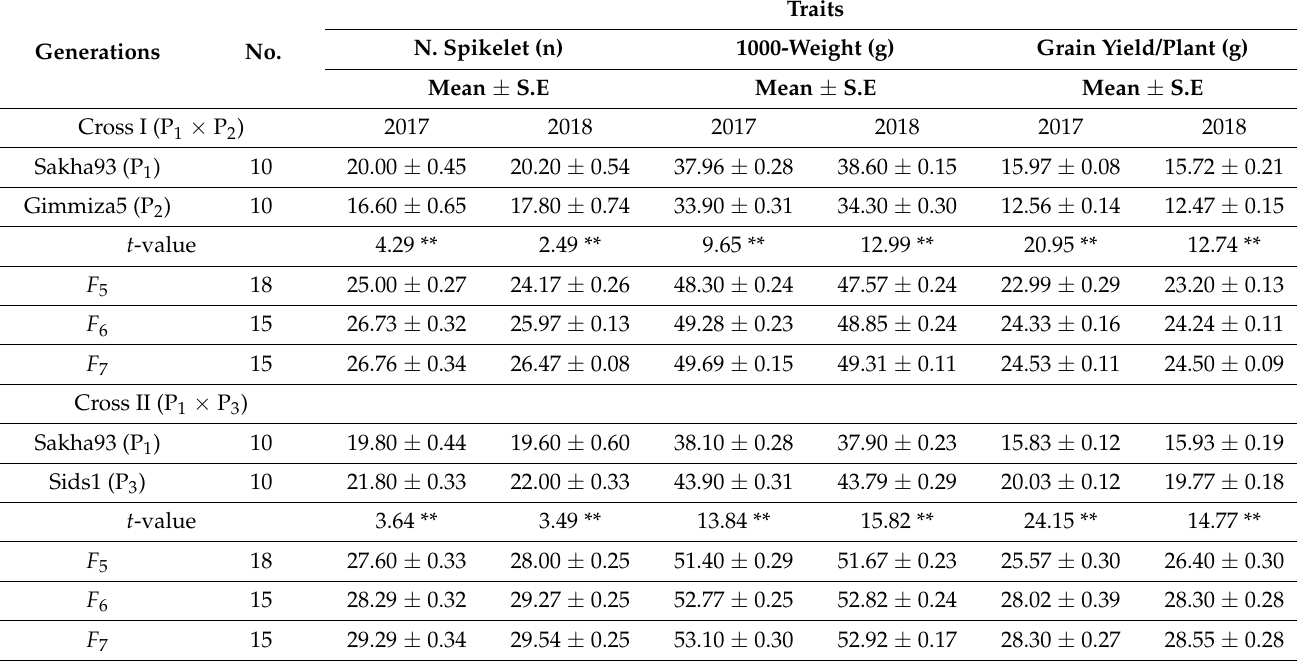
Table 3. Mean performance of the three traits studied in five generations of wheat in two seasons. Traits N. Spikelet (n) 1000-Weight (g) Grain Yield/Plant (g) Generations No. Mean ± S.E Mean ± S.E Mean ± S.E Cross I (P 1 × P 2